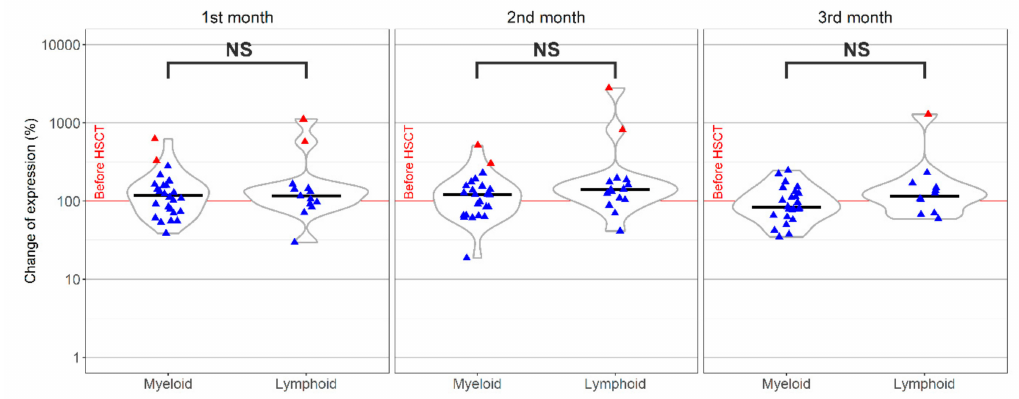
Figure 5. KIR3DL1 expression showed minimal changes, but slight di ff erences ( p = 0.06, on the border of statistical significance) were detected between myeloid malignancies and the lymphoid group. NS, without statistical significance; outliers, ; Median,